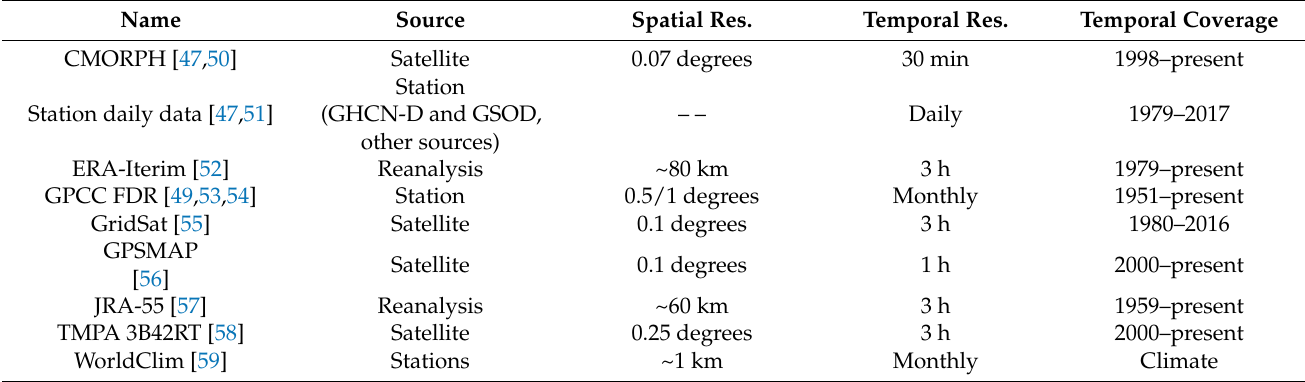
Table 1. Overview of datasets incorporated via grids in the MSWEP v2 database. Adapted from